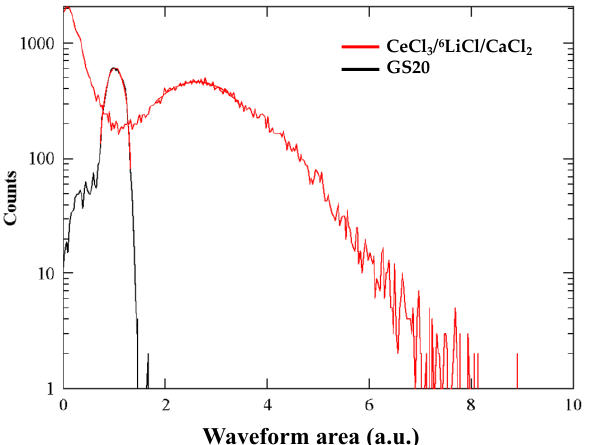
Figure 7. Pulse-height spectra of the CeCl 3 / 6 LiCl/CaCl 2 eutectic and GS20 standard under 252 Cf thermal neutron irradiation.